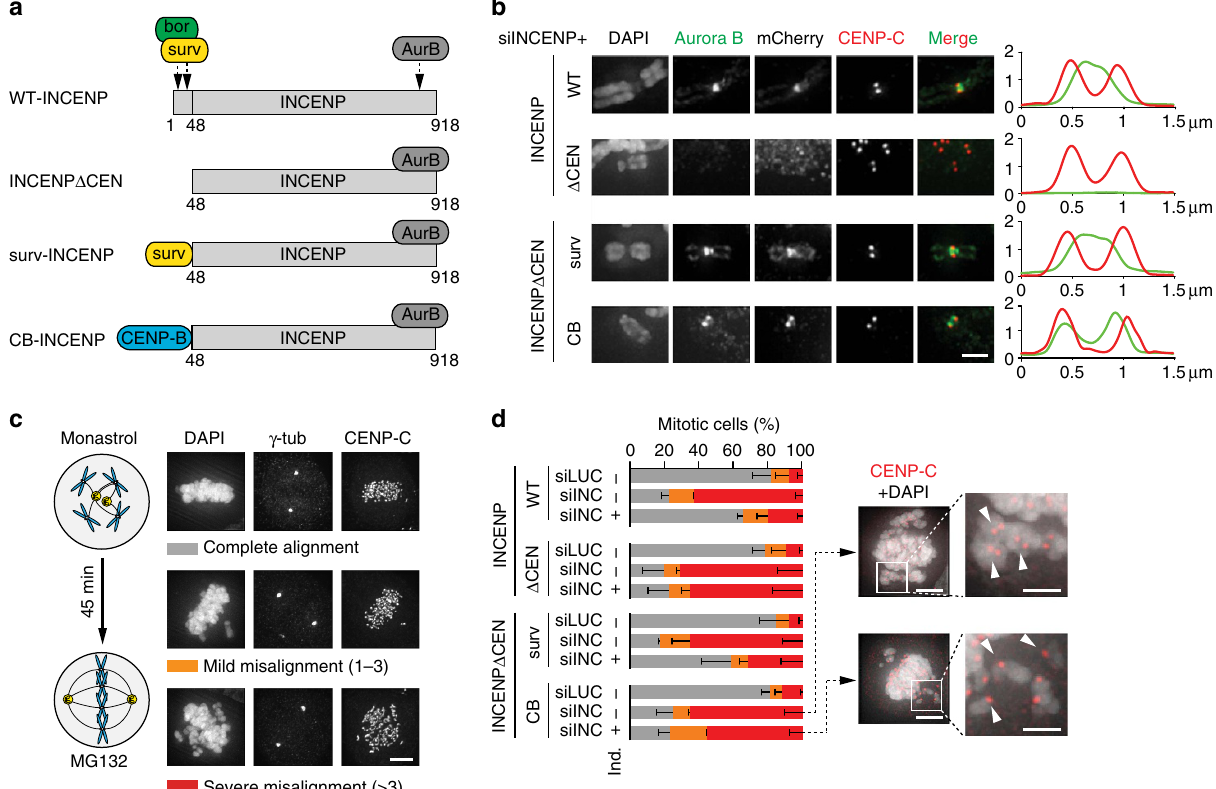
Figure 1 | Inner centromere localization of the CPC is required for stable chromosome bi-orientation. ( a ) Scheme of human CPC (bor, borealin; surv, survivin; AurB, Aurora B) and of INCENP D CEN (deletion of aa 1–48), survivin-INCENP D CEN (surv-INCENP) and CENP-B-INCENP D CEN (CB-INCENP). In all experiments HeLa Flp-In T-REx cells expressing the indicated mCherry-tagged INCENP variants were used. þ ind., expression induced by doxycycline, (cid:2) ind., no induction of expression. ( b ) IF of Aurora B, RFP (to detect mCherry), and CENP-C on chromosome spreads of nocodazole treated cells. 1D line graphs of Aurora B (green) and CENP-C (red) are shown on the right. Scale bar, 2 m m. Of note, although surv-INCENP and Aurora B accumulate at the inner centromere, in surv-INCENP-expressing prometaphase cells we also observed some localization of surv-INCENP and Aurora B over the chromosomal arms. Since survivin directly interacts with pH3T3 (refs 47,48) and we frequently detected pH3T3 along the chromosomal arms, this most likely explains the additional arm localization. ( c ) Scheme of the bi-orientation assay (that is, release from a monastrol-induced mitotic arrest into medium containing MG132) and examples of the alignment categories. Scale bar, 5 m m. ( d ) Cells were transfected with siRNAs for Luciferase (siLUC) or INCENP (siINC) and subjected to the bi- orientation assay and chromosome alignment was assessed ( n ¼ 2 exp., Z 150 cells per condition, error bars are s.e.m.). Representative images of two conditions (scale bar, 5 m m), and enlargements of selected image regions are shown on the right (scale bar, 2 m m). DNA is visualized using